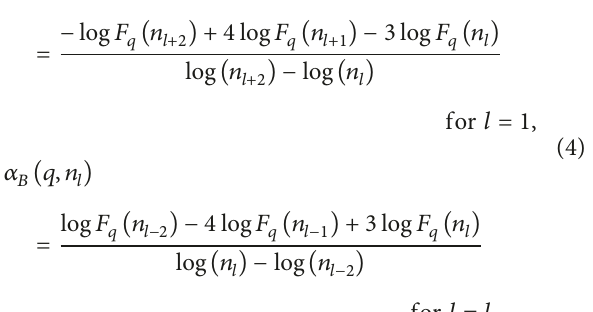
The multifractal exponent 𝛼(𝑞) can be estimated from (𝑛) in (2) as the slope of a least-square linear 𝐹 𝑞